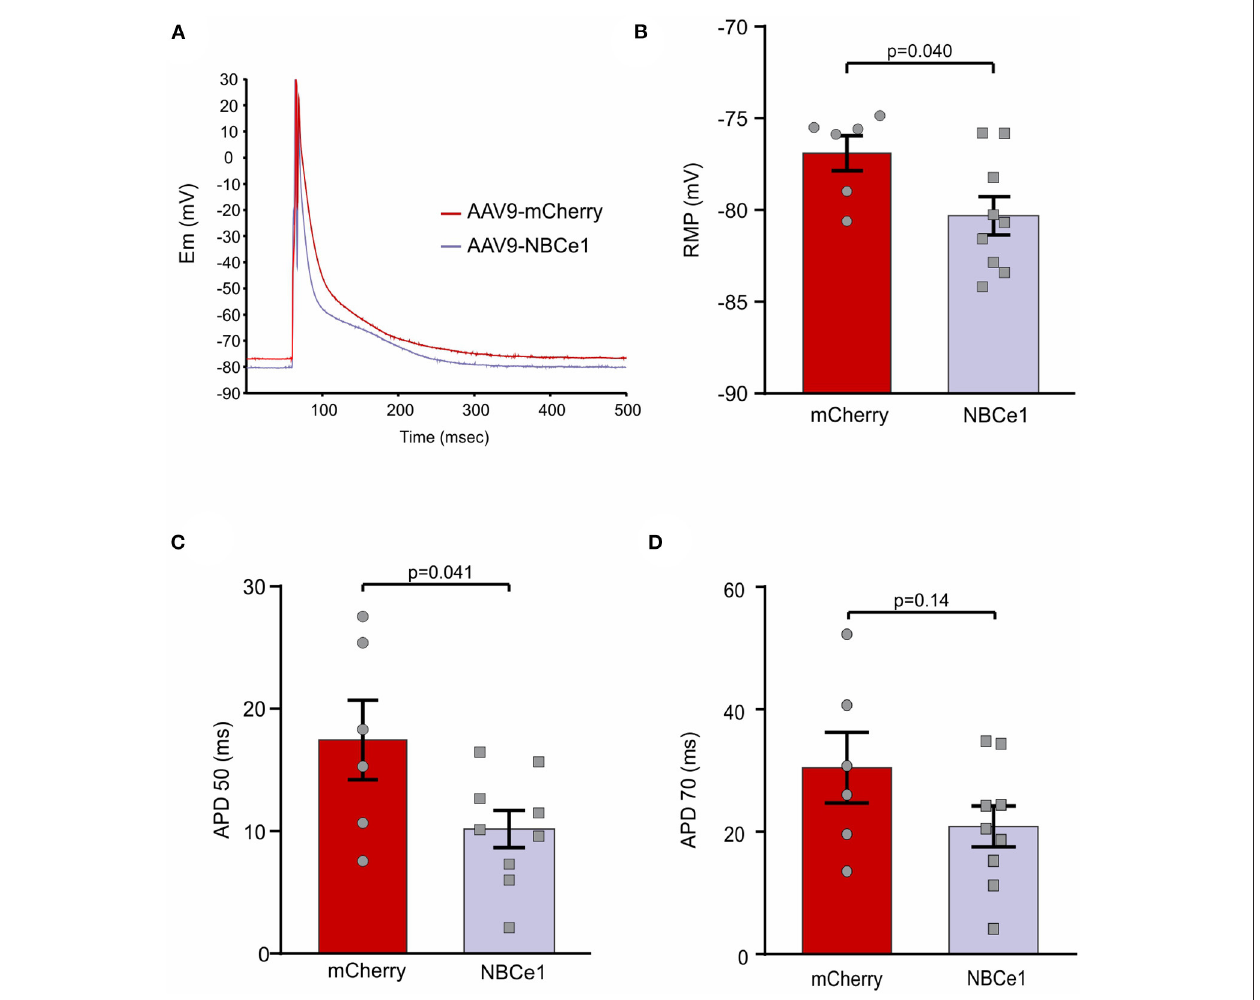
FIGURE 2 | Action potential recordings. (A) Representative recordings of action potential (AP) in cardiomyocytes from mice after 28 days of transduction with AAV9-mCherry and AAV9-NBCe1. These representative traces of action potentials are the average of all the traces used for the electrophysiological parameters measured in this work. These traces were aligned at the peak of the action potentials. (B) Quantitative analysis of resting membrane potential (RMP). Mice overexpressing NBCe1 presents a significant hyperpolarization of RMP. (C,D) AP duration at 50% [ (C) APD50) and 70% [ (D) APD70] of repolarization. Statistical analysis was done by t -student test after Shapiro–Wilk normality test, p < 0.05 was considered significantly different.